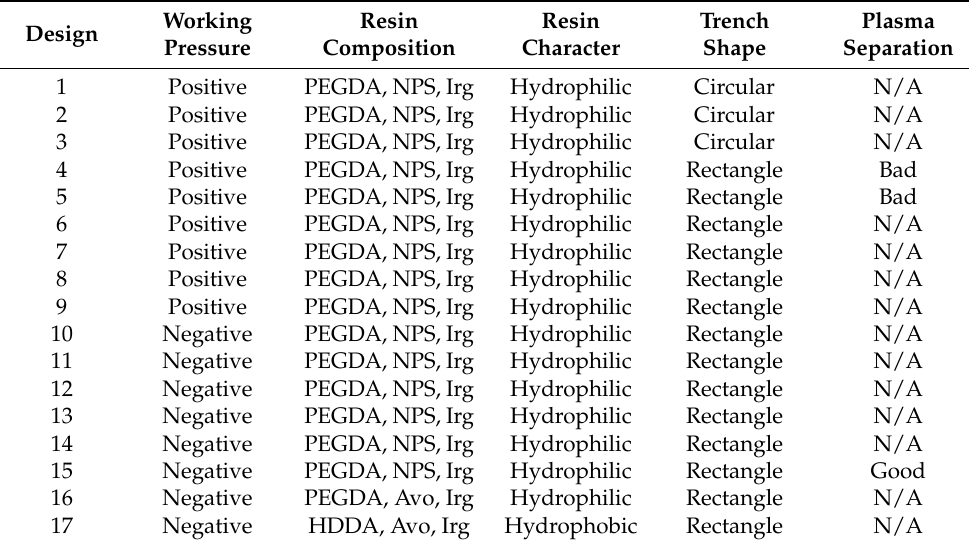
Table 1. Fabrication specifications of the 3D-printed